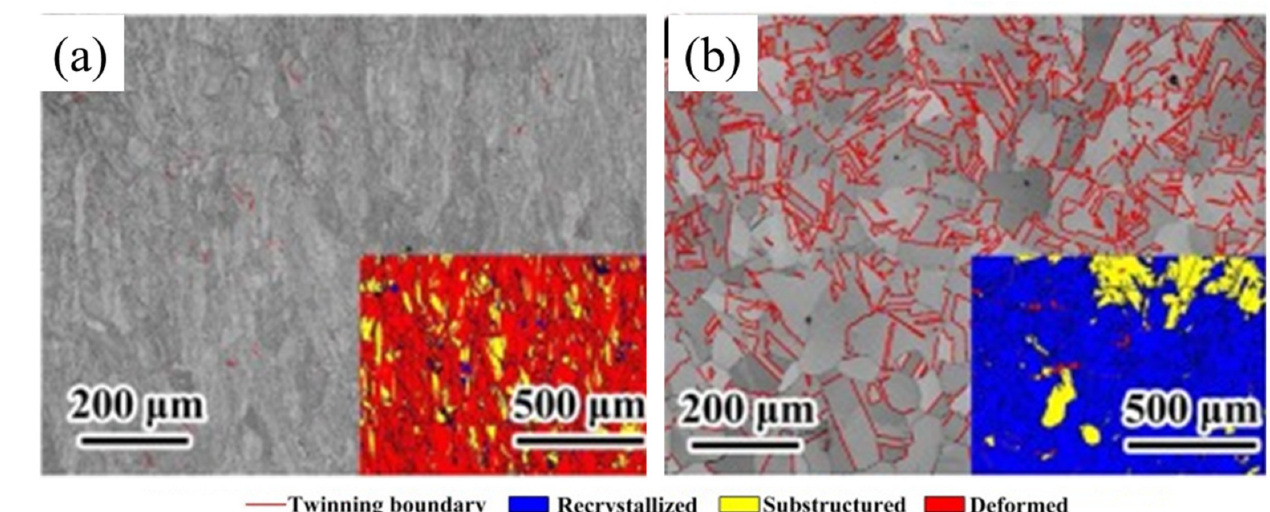
Figure 12. Distribution of twinning for CoCrFeNi HEA in ( a ) as-built and ( b ) annealed at 1300 ◦ C for 2 h conditions, indicating higher density of twinning after annealing. Insets show recrystallization distribution map. Reprinted with permission from ref. [355]. Copyright 2021